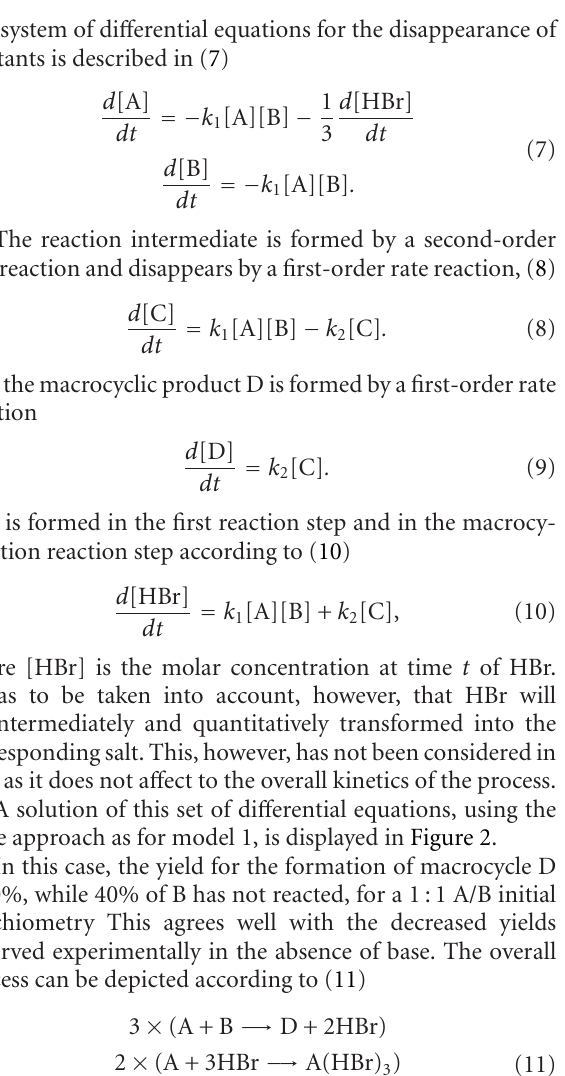
molar ratios A/B at di ff erent reaction times for kinetic model 2. [A] 0 = [B] = 0.005 M, k = 10M − 1 min − 1 and k = 0.05min − 1 0 1 2